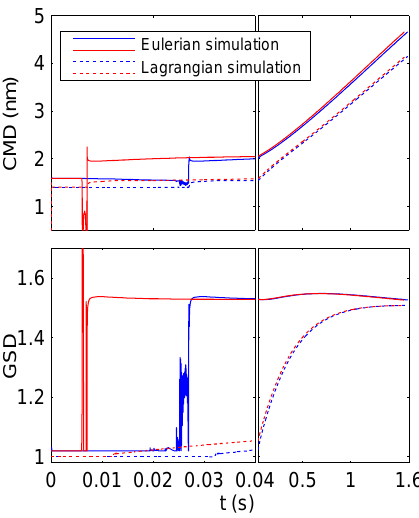
Figure 14. CMD vol and GSD vol as a function of time on the path lines. Note the different timescales.